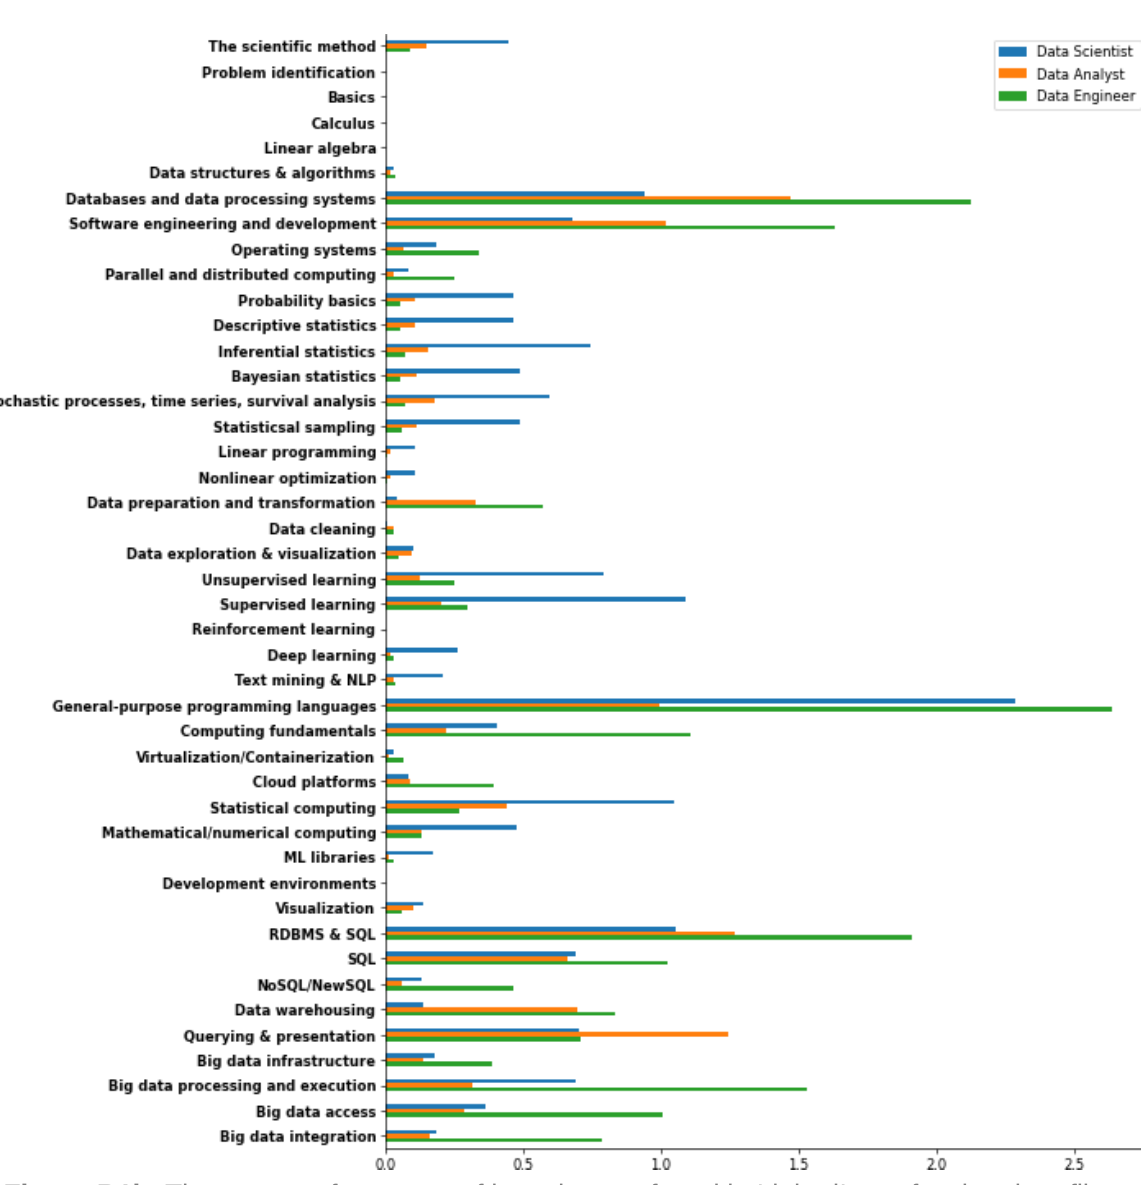
Figure B1b. The average frequency of key phrases found in LinkedIn professional Figure B1. Average frequency of key phrases (grouped by subjects based on the assignments in Table 1) in LinkedIn job postings (a) and professional profiles (b).